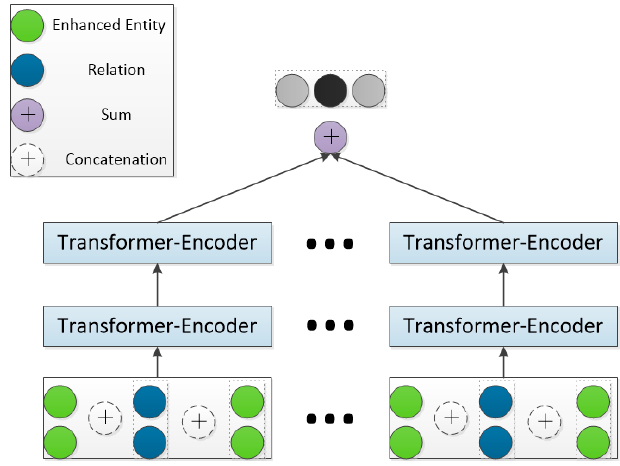
Figure 4. The main structure of the neighbor encoder.